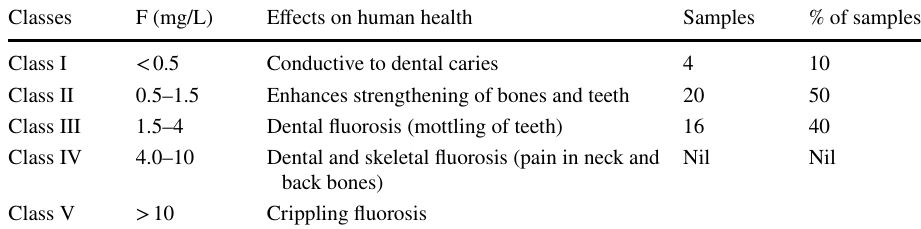
fluoride ingestion in individuals. Source : W.H.O.